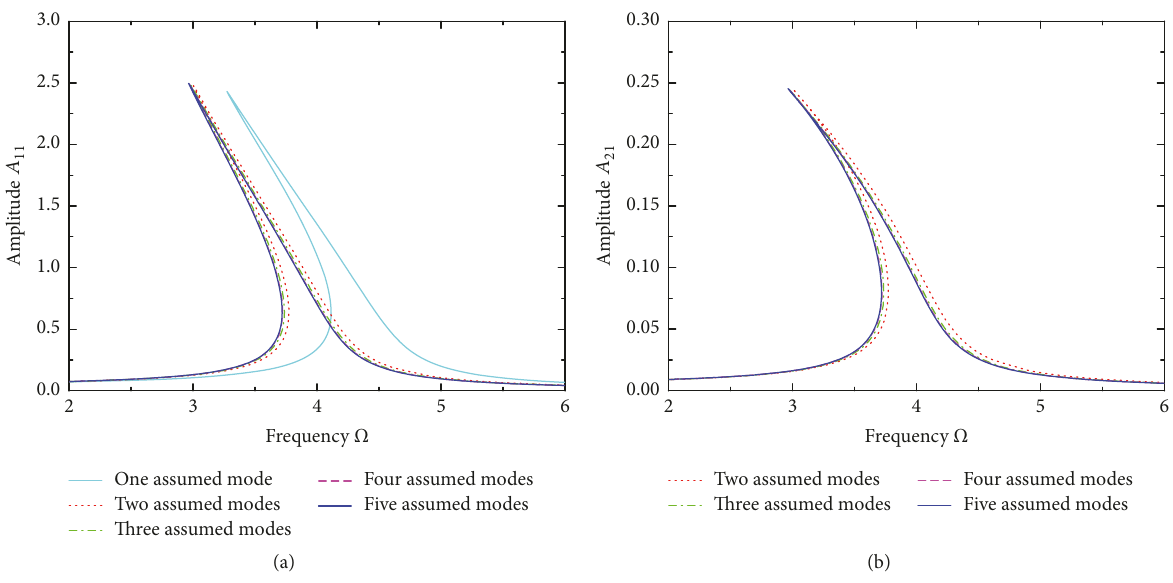
Figure 5: Nonlinear frequency response curves of the rotating hub-beam system with a tip mass for 𝑔 = 0.2 , 𝜉 = 0.01 , 𝑟 0 = 0.0909 , and 𝑚 = 0.035 , calculated using different numbers of included trial functions in (28): (a) Ω ∼ 𝐴 𝑡